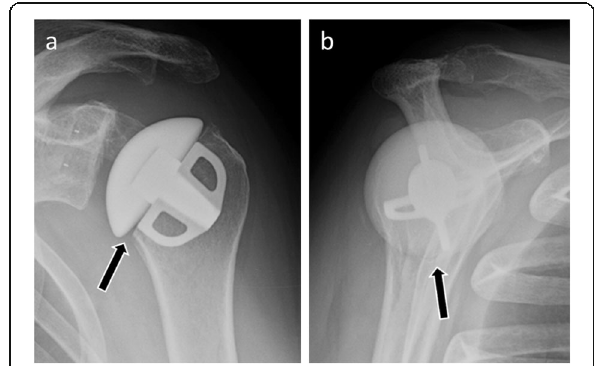
Fig. 4 Anteroposterior ( a ) and scapular Y ( b ) radiographs of normal findings in a patient with total shoulder arthroplasty. Note the stemless humeral component